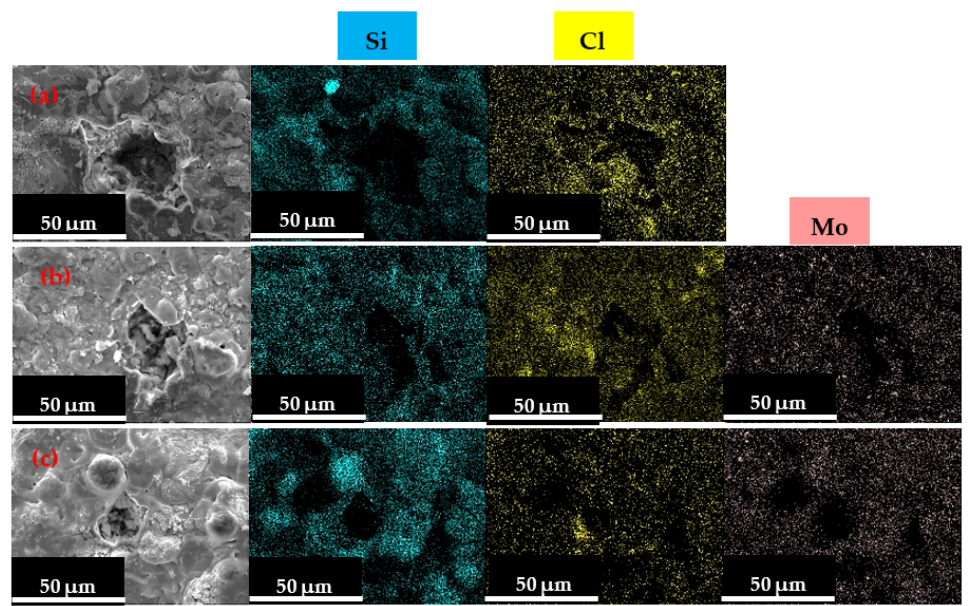
Figure 10. The variation of R in versus immersion time for the PEO coatings.